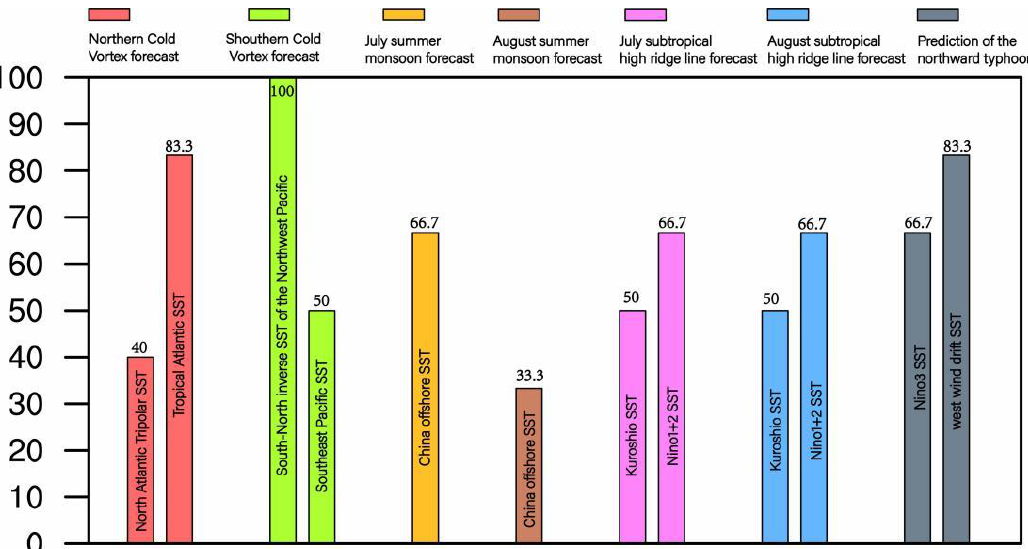
Figure 12. The prediction accuracy of influencing factors of flood-season precipitation in Liaoning.